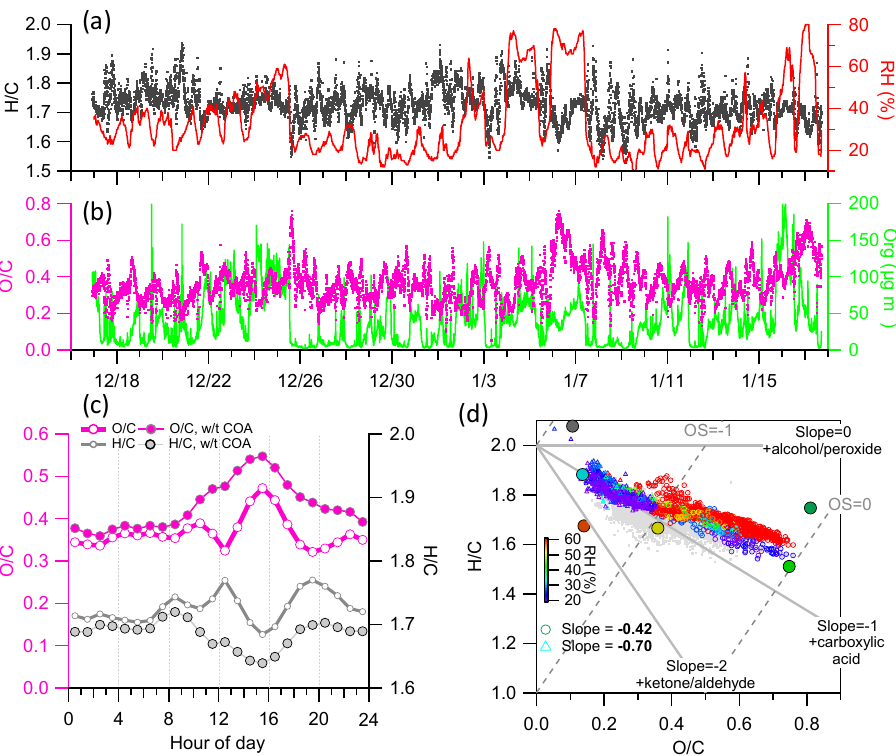
Figure 5. Time series of (a) H / C and (b) O / C ratios, (c) average diurnal cycles of O / C and H / C. Also shown are the average diurnal cycles of elemental ratios by excluding the contribution of cooking organics aerosol and (d) Van Krevelen diagram of H / C vs. O / C. The RH colour-coded triangle and circle points represent the data with the contributions of aq-OOA and COA being larger than 20 and 40%,